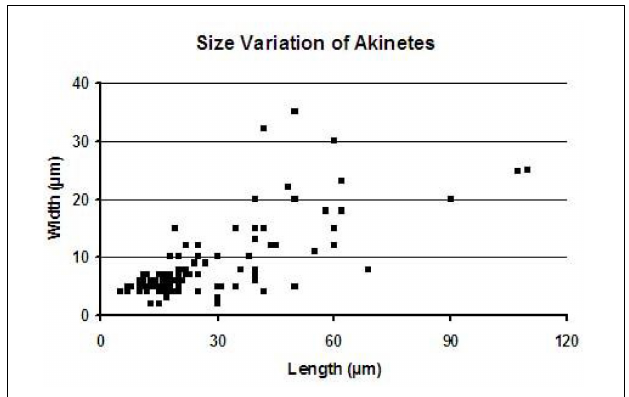
FIGURE 4 | Size variation diagram of akinetes occurring in the thin section of cherts from the Salkhan Limestone.